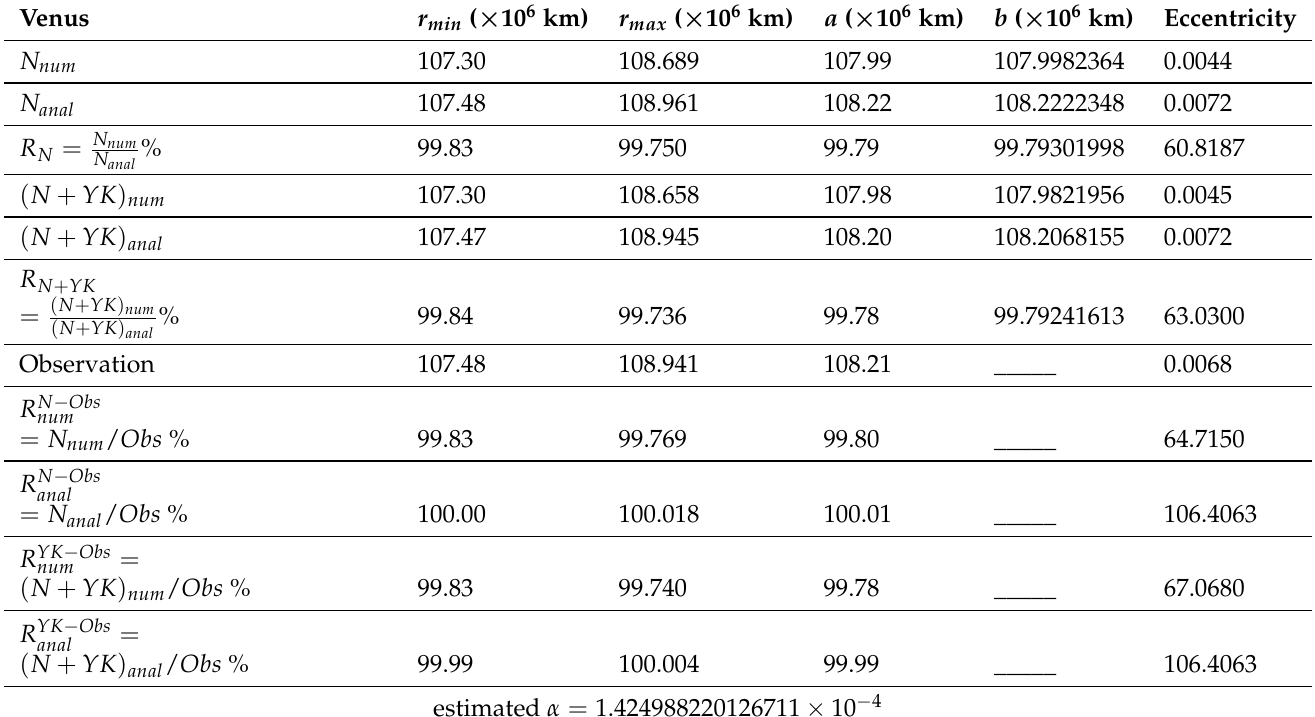
Table A4. The values of the calculated and observational astronomical parameters, for estimated α , of the planet Venus, whose number of moons is 0.